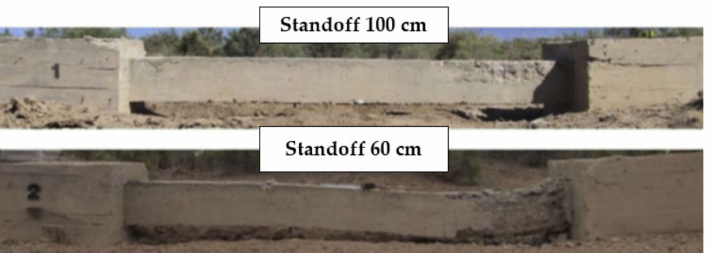
Figure 11. Damage of the RC columns after detonation at 100 cm and 60 cm standoff [14]. Copyright permission obtained from